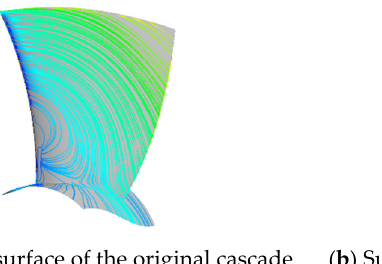
Figure 17. Surface streamline comparisons of Blade D500.